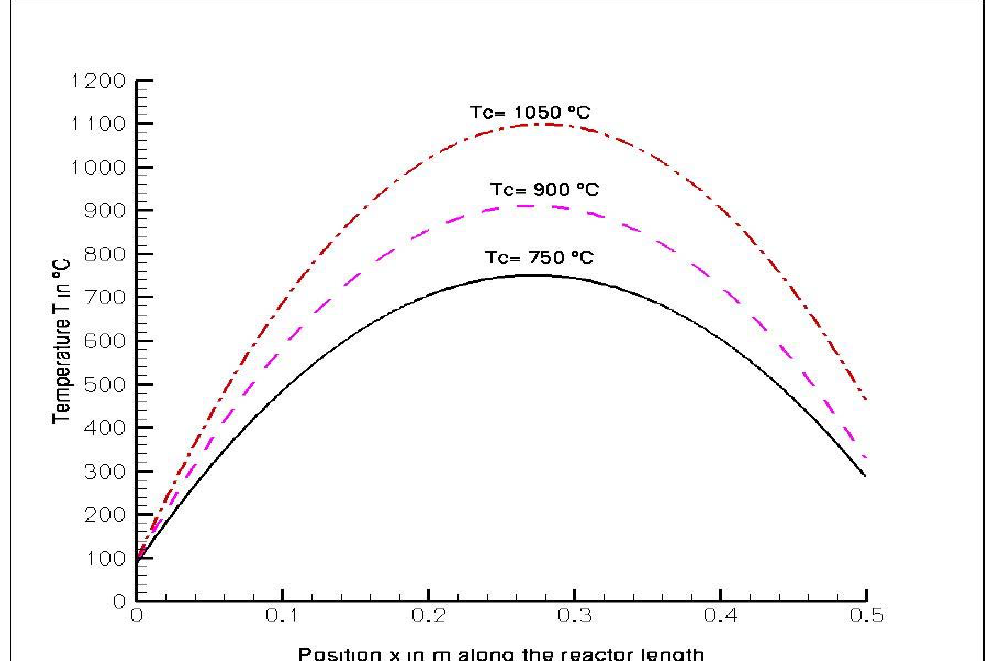
Figure 1. Temperature profiles at selected controller temperatures